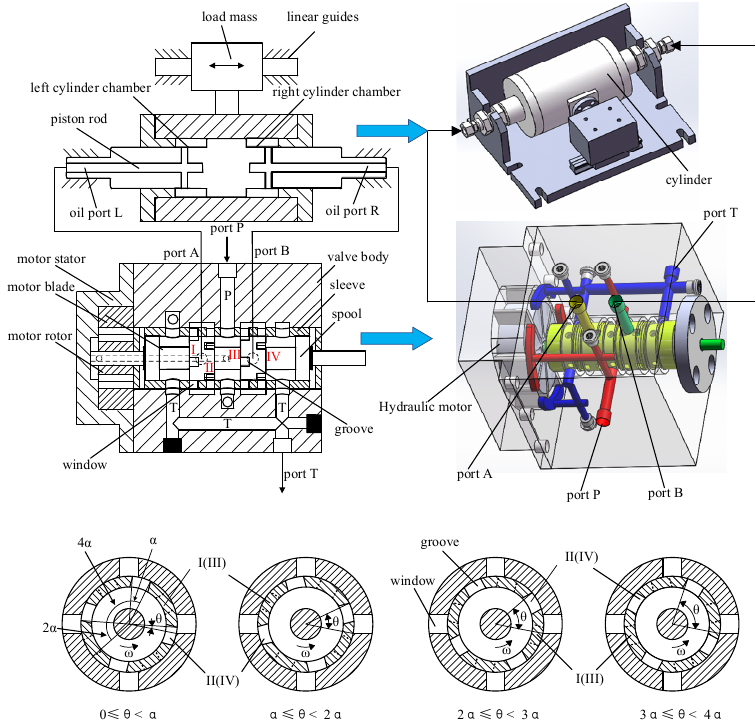
Figure 2. Working process of the hydraulic controlled rotary valve exciter.